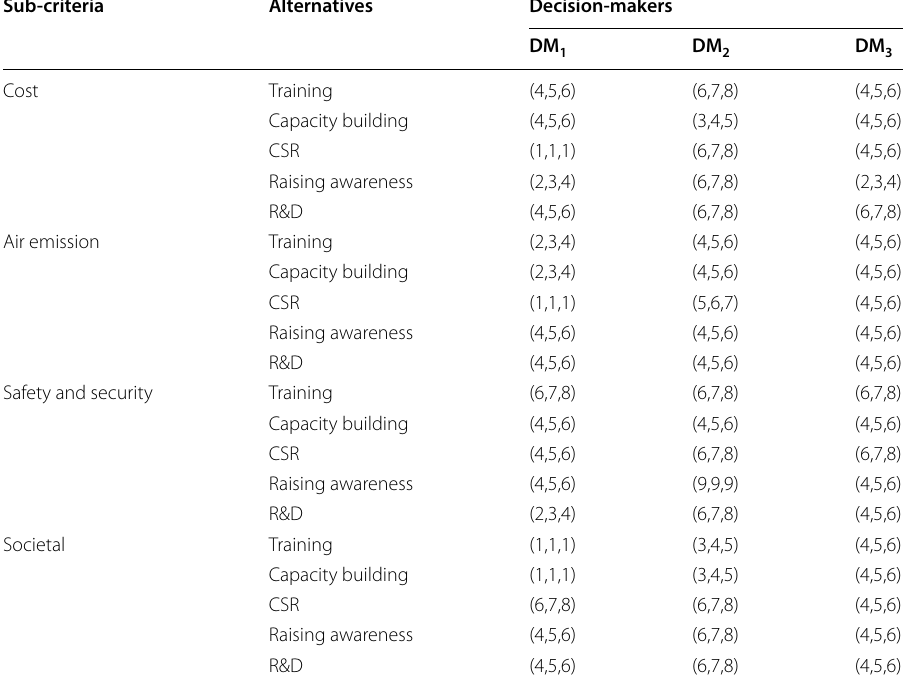
Table 16 Rating of the alternatives by three decision makers under the sub-criteria Sub-criteria